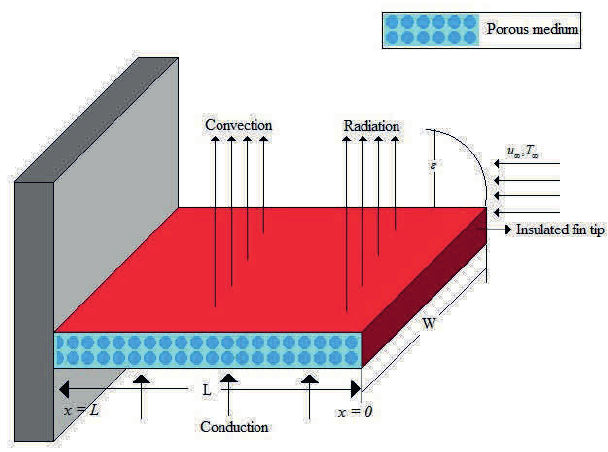
Fig. 1: The geometry of a rectangular fin profile.